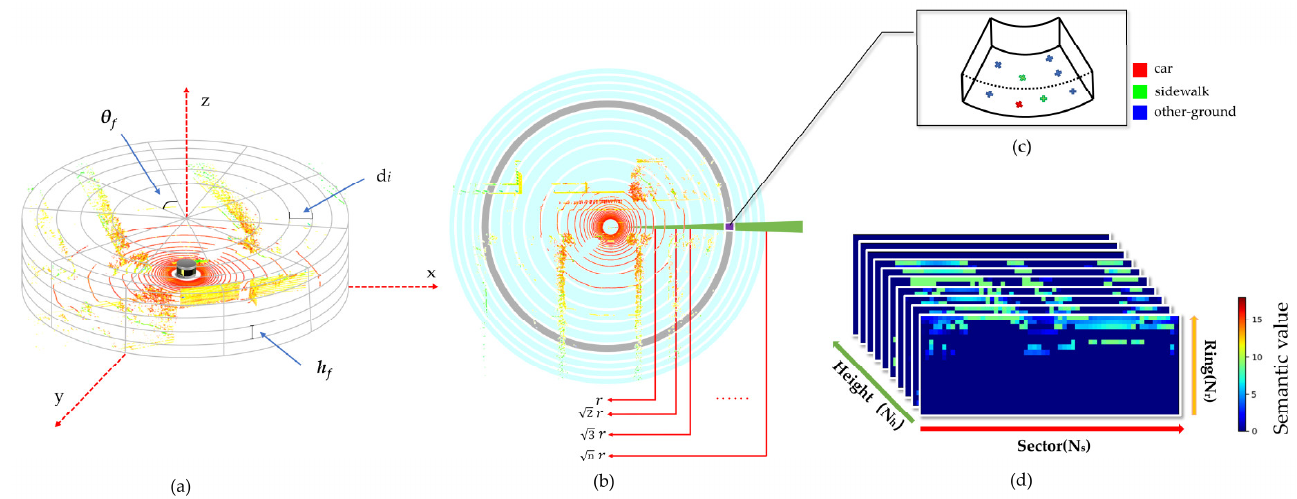
Figure 3. 3PCD-TP construction process. ( a ) The segmentation process of point clouds; ( b ) top-view projection of point clouds, the way to divide the ring is marked with a red arrow; ( c ) visualization of bins. Red points mean car, green points mean road, blue points mean other ground; ( d ) the 3D tensor generated from point clouds. The different colors mean 18 different tags that can represent the current bin.